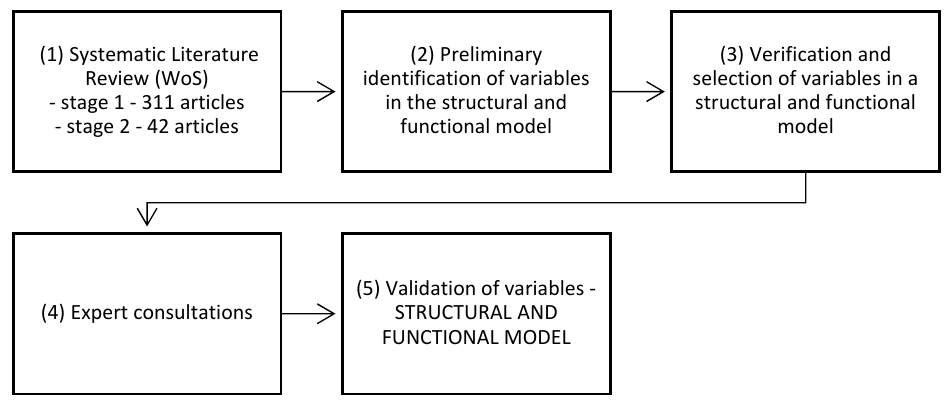
Figure 1. Panel scheme of the conducted research. Source: own elaboration.